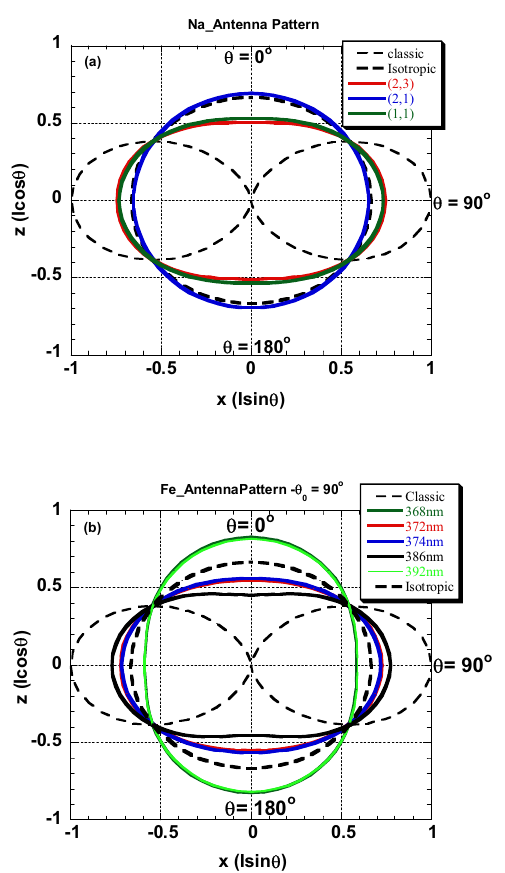
Fig. 3.1. Radiation patterns of the z-polarized, with fluorescence intensity as a function of scattering angles for (a) Na D 2 and (b) 56 Fe transitions. In (a), the Na (2,2), (1,2) and (1,0) excitations exhibit spontaneous emission behavior (bold-black dashed) with a backward scattering value of interest to the isotropic . In (b), none of the Fe transitions exhibits spontaneous emission behavior (shown in bold-black dashed for reference). All transitions, shown in solid lines, exhibit the Hanle Effect. In both figures, for comparison the classic dipole pattern is shown in the thin-black dashed